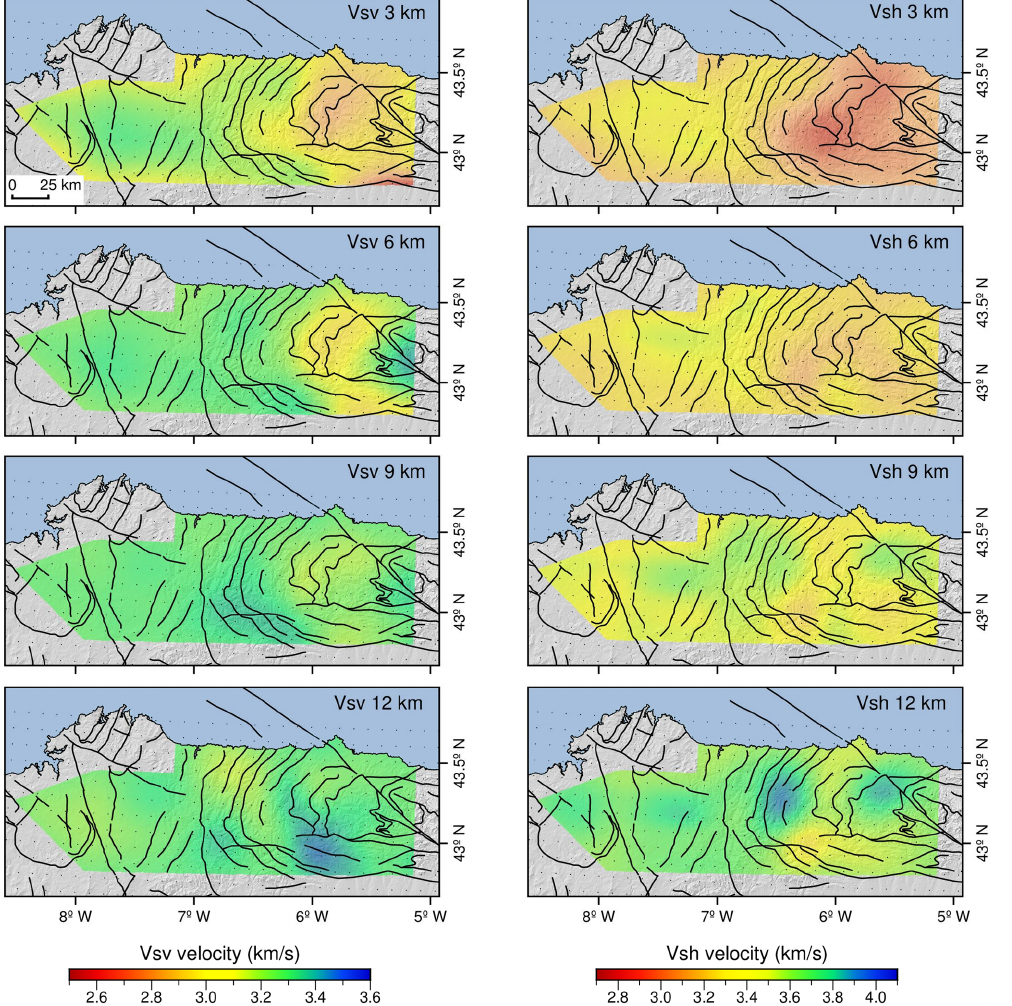
Figure 6. Inverted V sv (left panels) and V sh (right panels) velocity tomographic maps for depths of 3, 6, 9, and 12km. Black lines represent the main Alpine and Variscan faults. The point grid marks the position of each inverted V s depth